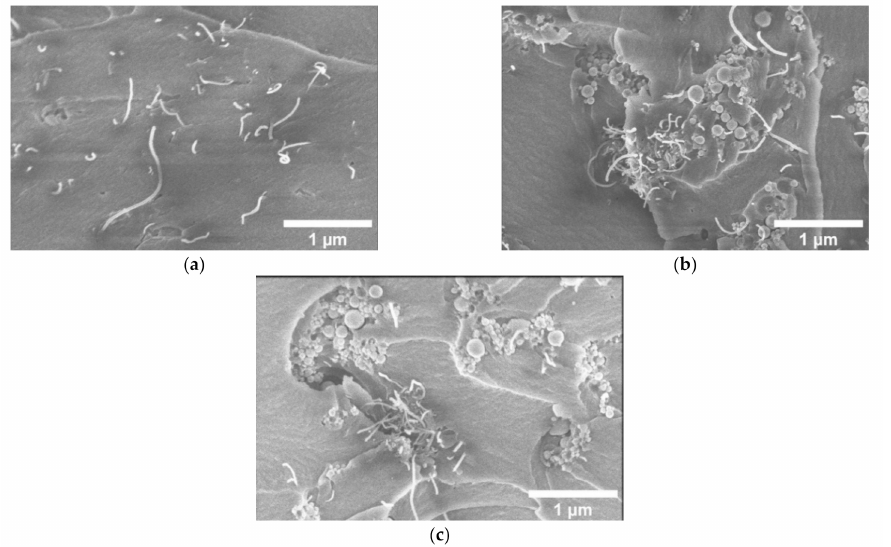
Figure 3. Scanning electron microscopy micrographs of hybrid Ni@C/MWCNTs/epoxy resin com- posites with 0.09 vol.% of MWCNTs and ( a ) 0, ( b ) 0.6 and ( c ) 1 vol.% of Ni@C.